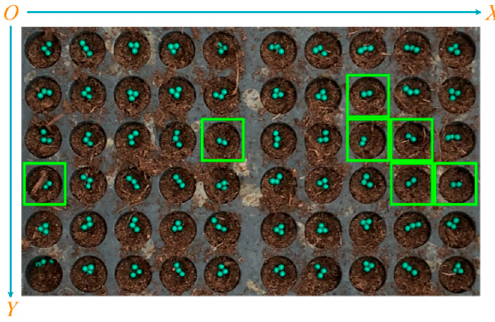
Figure 14. Image processing results.